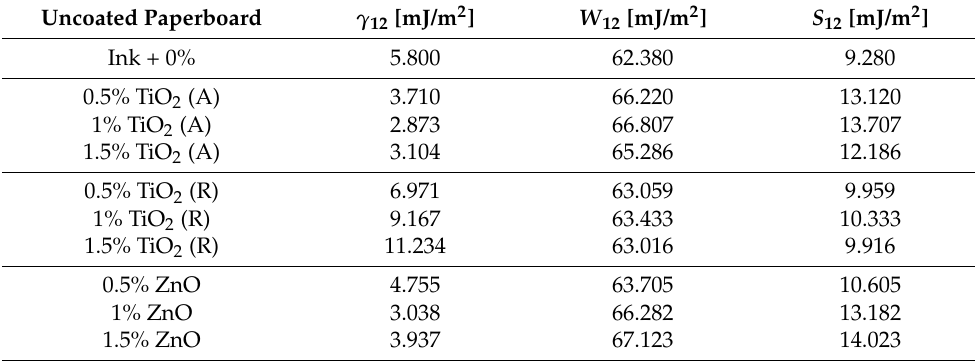
Table 3. Adhesion parameters on uncoated paperboard.